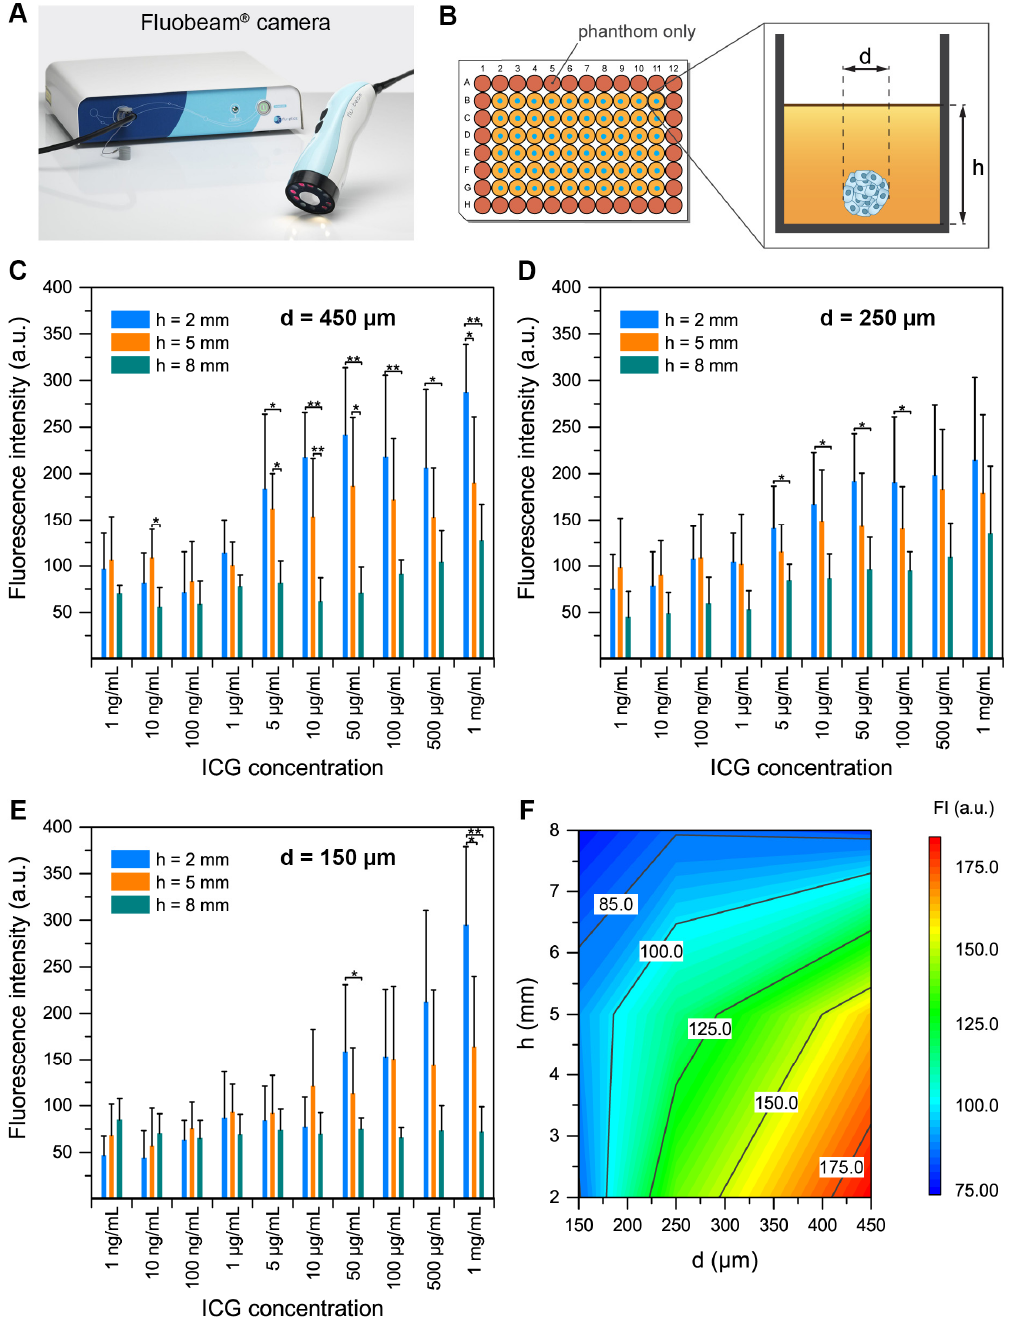
Figure 4. Detection in tissue-like phantoms of spheroids incubated for 24 hours with ICG using the Fluobeam® camera. ( A ) Photo of the Fluobeam® camera. ( B ) FaDu spheroids (150 to 450 µm in diameter (d)) incubated for 24 hours with ICG (1 x 10 − 6 to 1 mg/ml) were placed onto the phantom and then covered with different heights (h) of the phantom. ICG was excited with a wavelength of 690 nm and the fluorescence emitted was detected by the Fluobeam® imager between 700 and 850 nm, with an exposure time of 150 ms. ( C ), ( D ) and ( E ) Detection of 450, 250 and 150 µm FaDu spheroids in 2, 5 or 8 mm of tissue-like phantom. The results are presented as mean ± SD with n = 4. ANOVA + Tukey post-hoc test. * p < 0.05; ** p < 0.01. The background signal from “phantom only” wells was subtracted for each sample. ( F ) Plot of ICG fluorescence intensity as a function of diameter (d) of spheroids and depth (h) in the phantom for a concentration of 5 µg/ml of ICG.